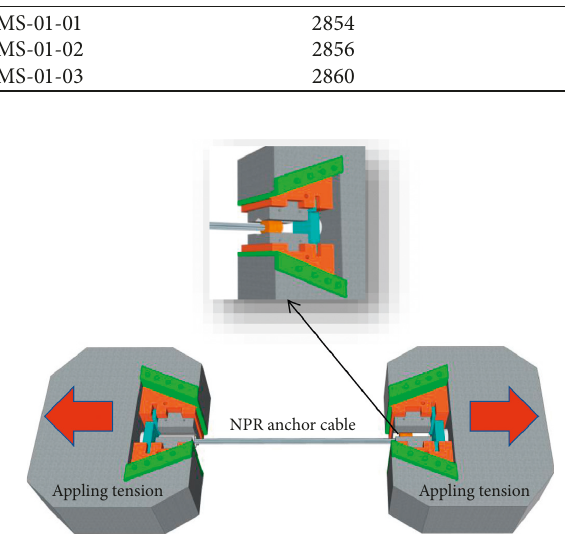
Figure 3: Schematic diagram of the static stretching system.